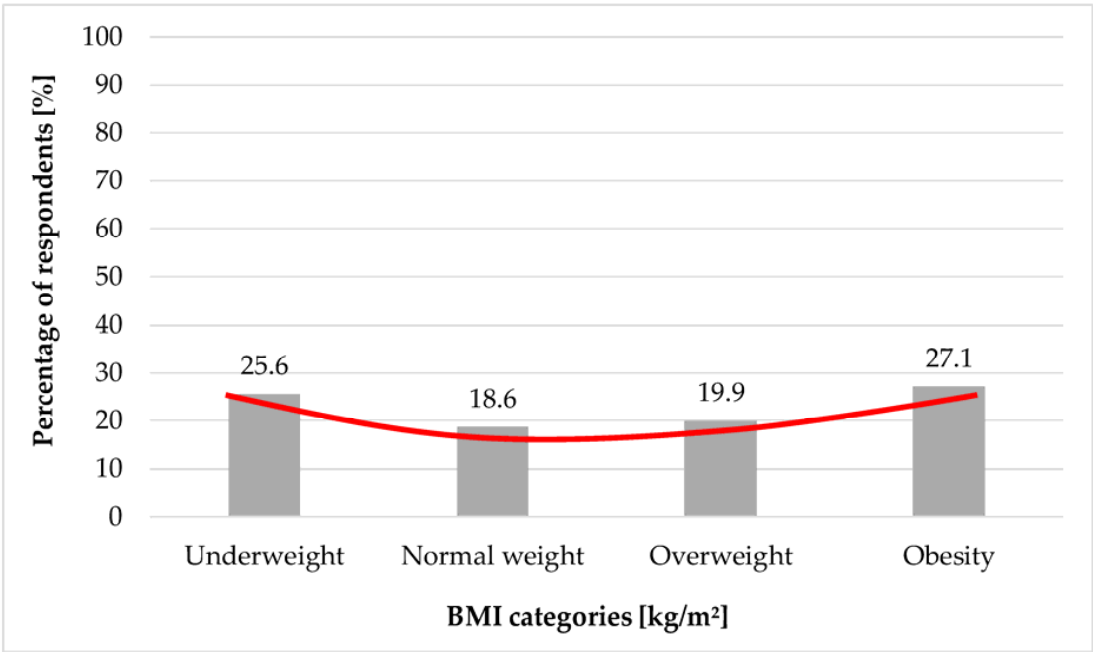
Figure 2. Percentage of individuals presenting a moderate depression index according to Beck’s scale ( p < 0.01). The red line represents the J-curve.